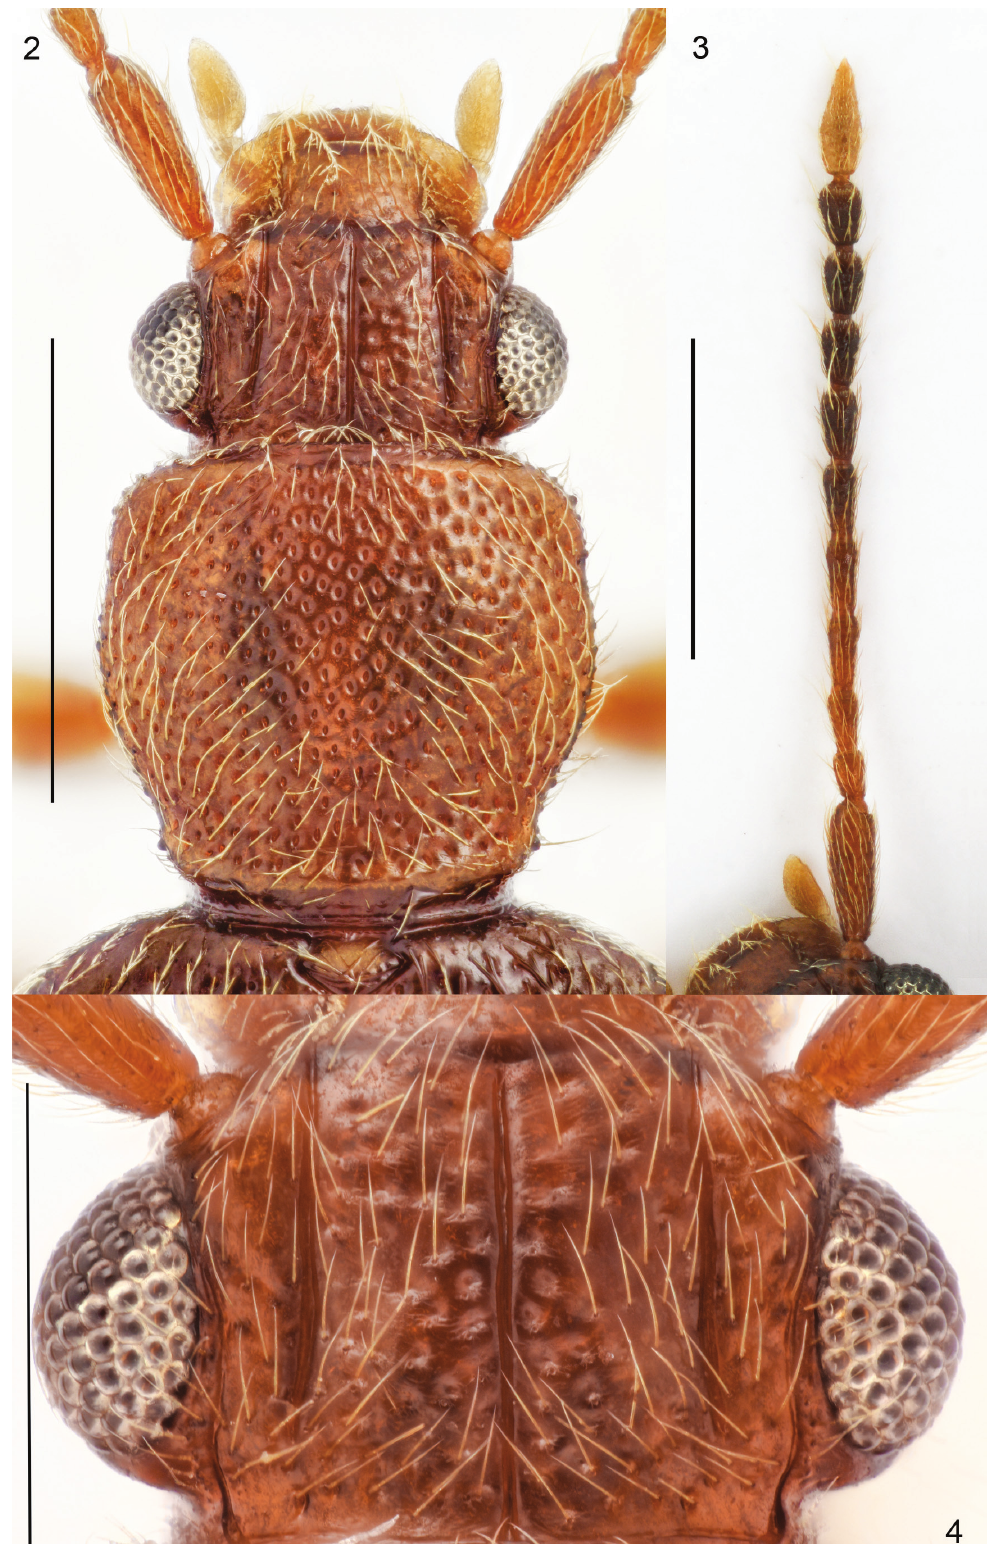
Figs 2–4. Bolianus giannae gen. et sp. nov., holotype. 2 . Head and pronotum. 3 . right antenna. 4 . Detail of head. Scale bars: 2–3 = 1.0 mm, 4 = 0.5